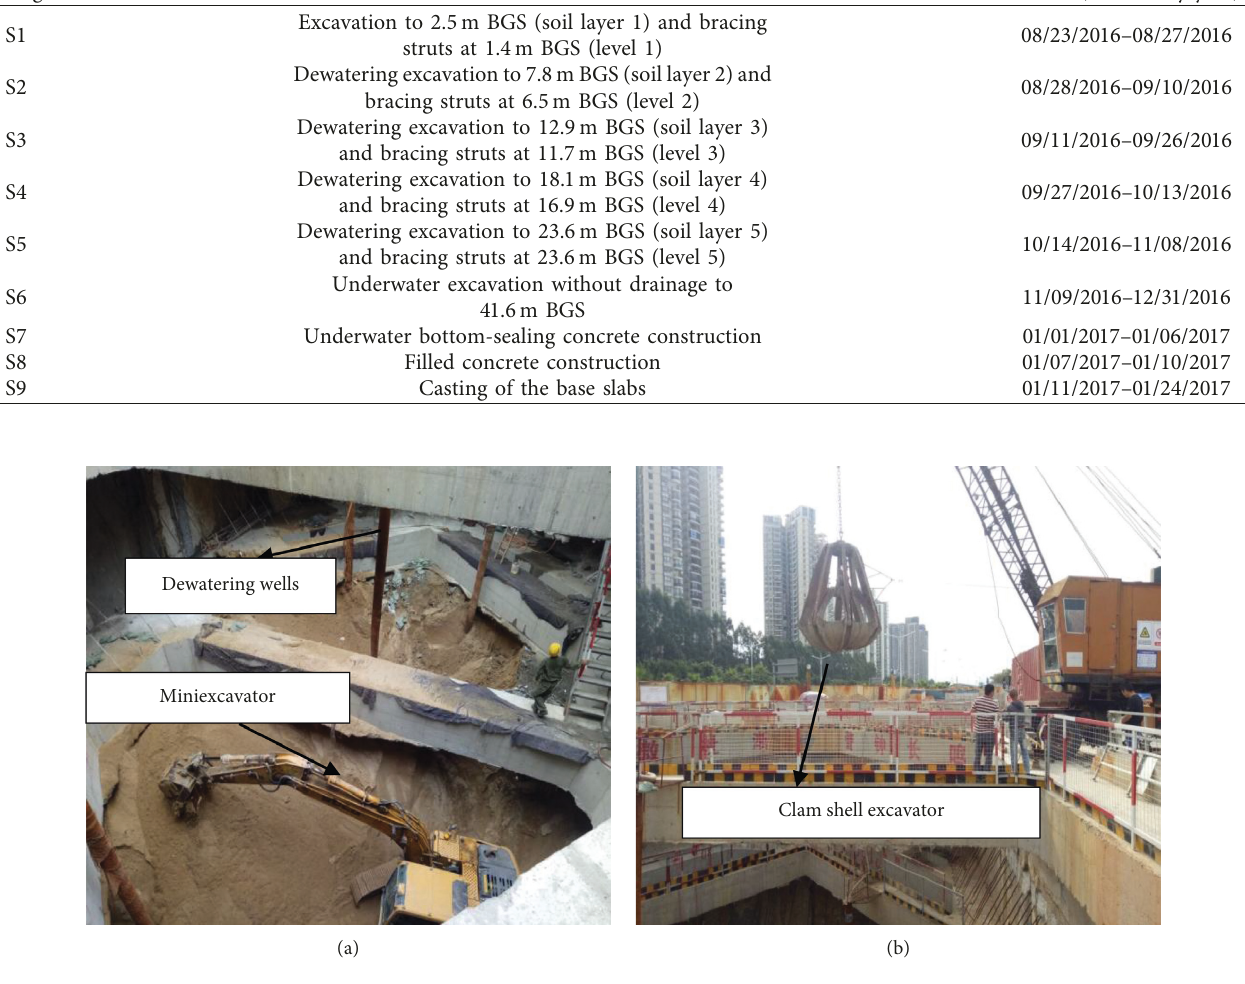
Figure 7: Dewatering and braced excavation.